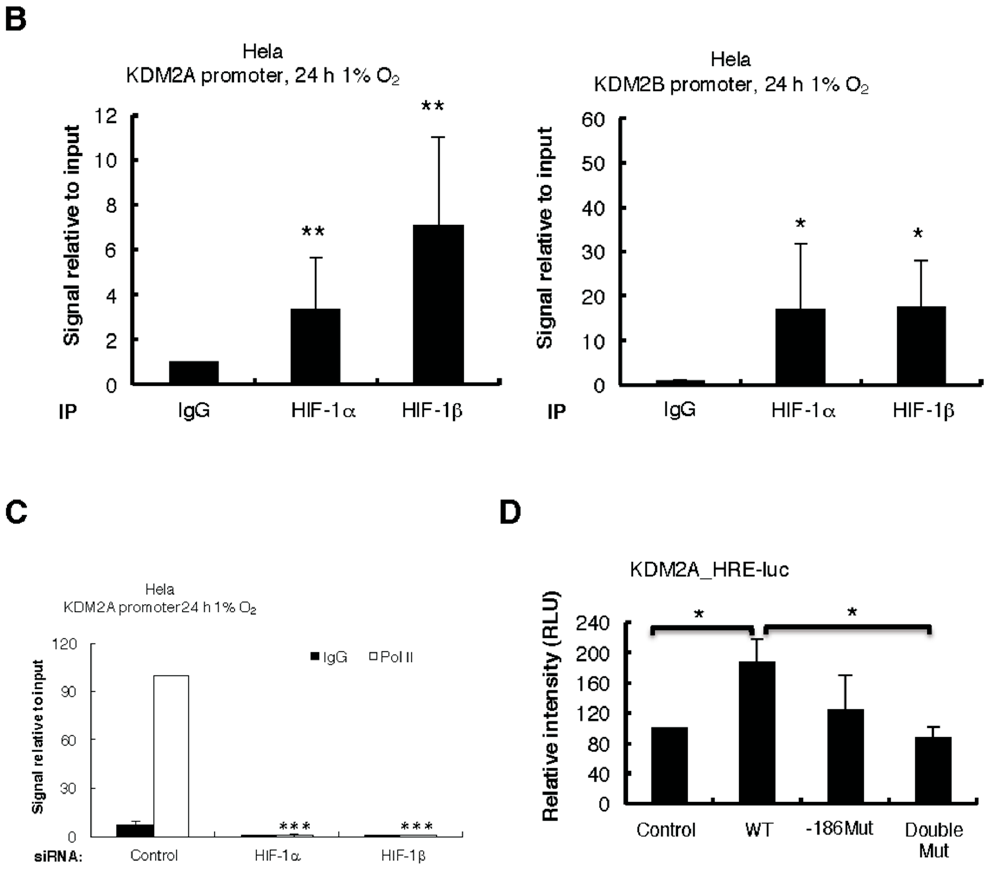
Figure 5. HIF-1 α /HIF-1 β heterodimer is present at the KDM2A promoter and is required for